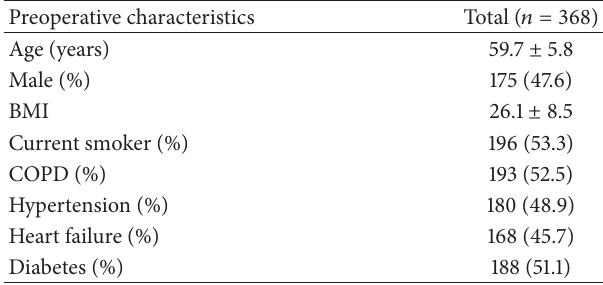
Table 2: Patient baseline